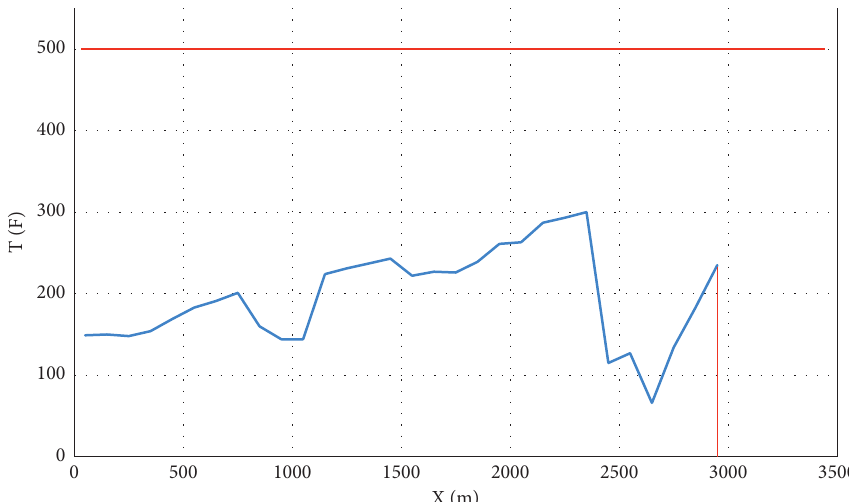
Figure 4: Brake temperature diagram along the route towards the police inspection